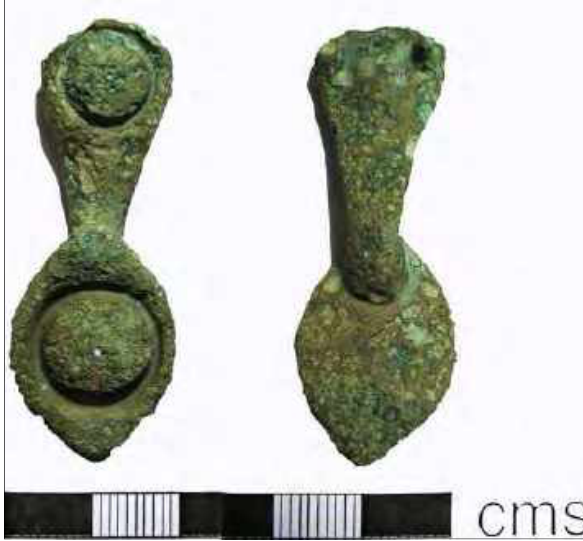
Fig 2.29 Late Iron Age cast copper alloy strap fastener from Cumbria